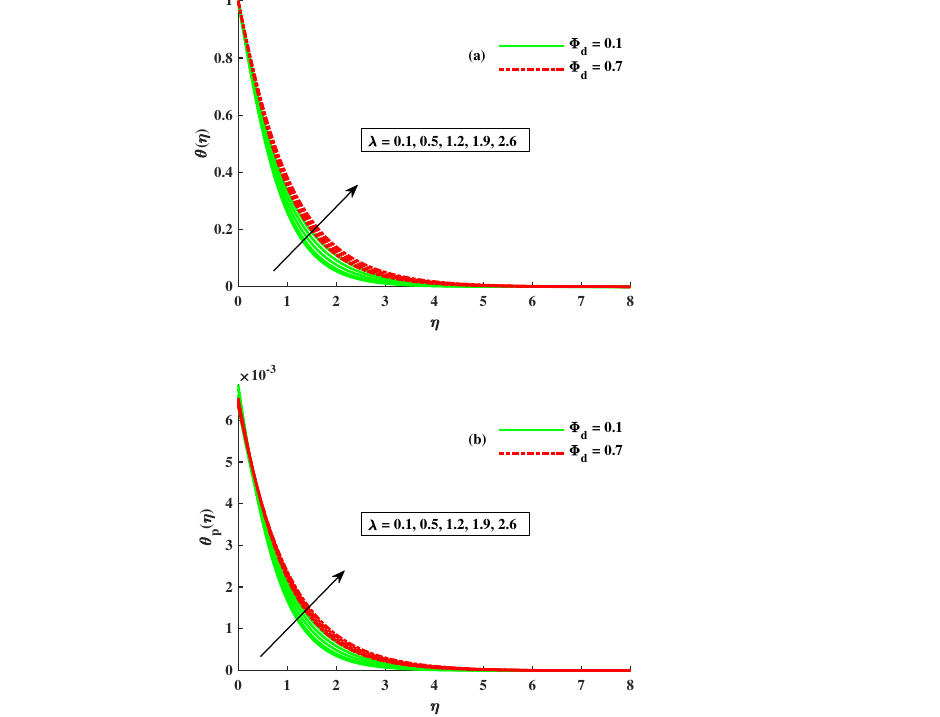
Figure 10. Influence of φ d & λ on ( a ) θ ( η ) & ( b ) θ p ( η ) .